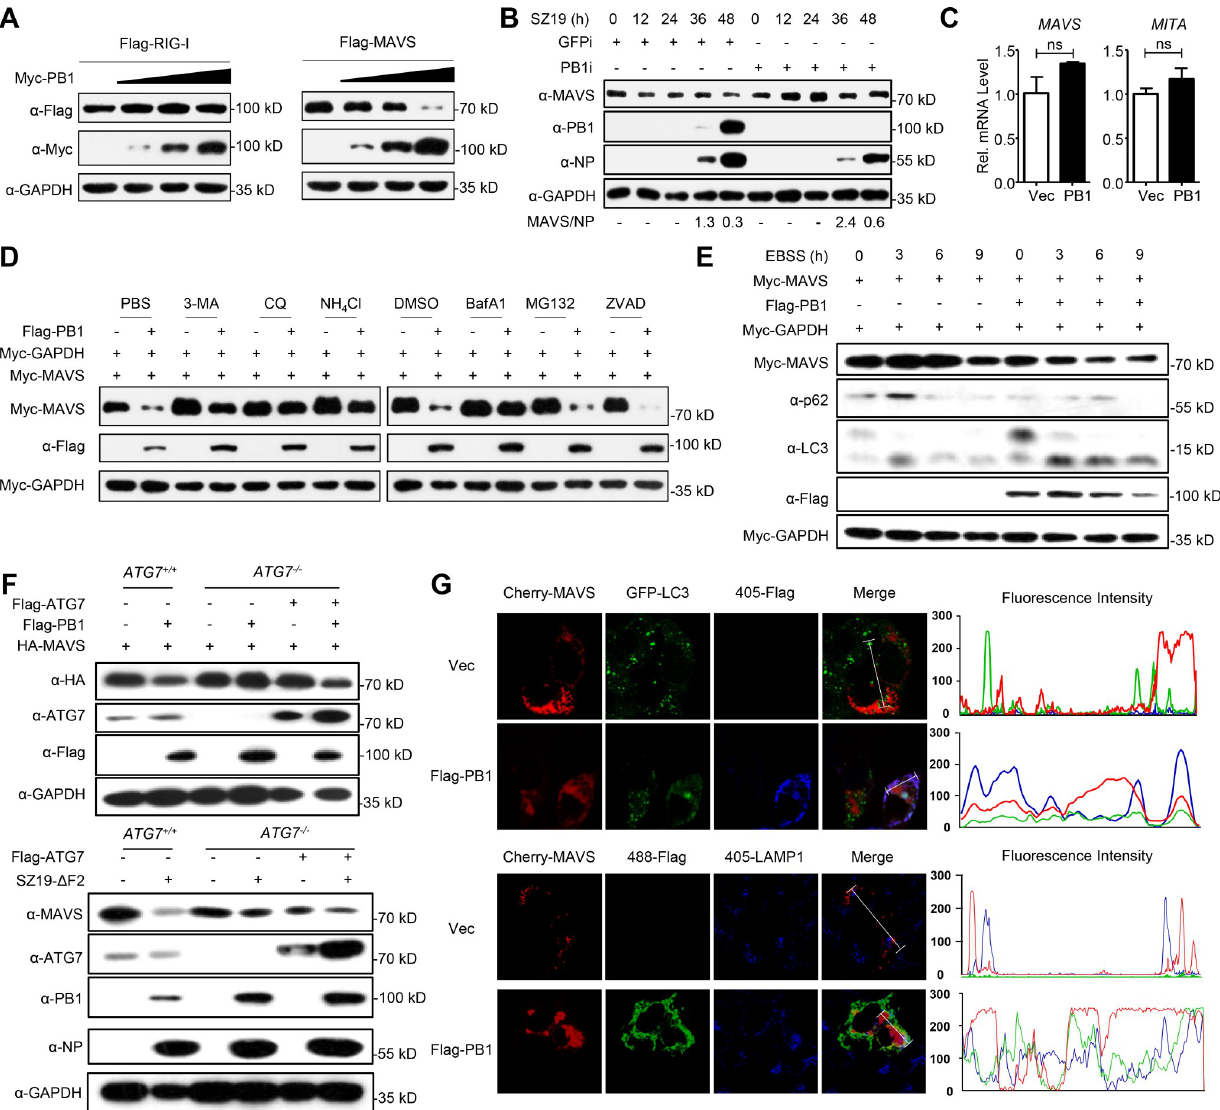
Fig 3. H7N9 PB1 promotes autophagic degradation of MAVS. (A) Overexpression of PB1 decreases the MAVS protein level. HEK293 cells transfected with Flag-MAVS or Flag-RIG-I with the increased amount of Myc-PB1 for 24 h before immunoblotting analysis. (B) PB1 decreases endogenous MAVS expression. A549 cells stably transduced with GFP-RNAi or PB1-RNAi were left uninfected or infected with SZ19 virus (MOI = 0.1) for the indicated times before immunoblot analysis with the indicated antibodies. The intensities of the indicated protein bands were determined by using image J, were normalized to NP, and are shown as the fold-change of MAVS/NP. (C) PB1 has no effect on MAVS mRNA expression. HEK293 cells were transfected with vector control or the PB1 plasmid for 24 h before qPCR analysis. (D) 3-MA, CQ, NH 4 Cl, and BafA1 blocked PB1-mediated MAVS degradation. HEK293 cells were transfected with the indicated plasmids for 20 h and then treated with 3-methyladenine (3-MA) (10 mM), chloroquine (CQ) (50 μ M), NH 4 Cl (20 mM), MG132 (10 μ M), bafilomycin A1 (BafA1) (0.2 μ M), or ZVAD (20 μ M) for 6 h. The cell lysates were then analyzed by immunoblotting with the indicated antibodies. (E) Activated autophagy increases PB1-mediated MAVS degradation. HEK293 cells were transfected with a plasmid encoding Myc-MAVS and Myc-GAPDH with or without Flag-PB1. At 24 h post-transfection, cells were treated with EBSS at the indicated time points and followed by immunoblot analysis. (F) ATG7 deficiency inhibits Flag-PB1- or SZ19- Δ F2 virus-mediated degradation of MAVS. Wild-type HEK293 cells or ATG7-deficient cells were transfected with the indicated plasmids for 24 h (up), or subsequently the cells were infected with SZ19- Δ F2 virus for another 24 h (down), followed by immunoblot analysis with the indicated antibodies. (G) PB1 co-localizes with MAVS at the autophagosomes and lysosomes. HEK293 cells were transfected with an empty vector or Flag-PB1 and the indicated plasmids. Twenty hours later, the cells were fixed with 4% paraformaldehyde and stained with anti-LAMP1 and / or anti-Flag before confocal microscopy. The fluorescence intensity profile of Cherry-MAVS (red), GFP-LC3 (green), and Flag (blue) or Cherry-MAVS (red), Flag (green), and LAMP1 (blue) was measured along the line drawn by Image J. The data shown represent three independent experiments; bars represent the mean ± SD of the three independent experiments (n = 3). (‘ns’ indicates no significant